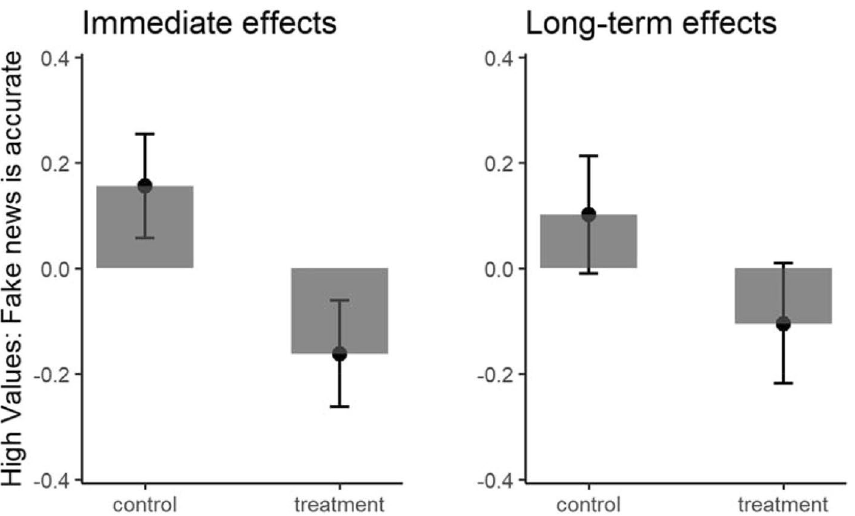
Figure 6. Accuracy evaluation of fake news immediately after the intervention (left panel) and 4 weeks later (right panel). Error bars represent standard errors. The y-axis represents standardized scores in terms of fake news accuracy ratings controlled for real news accuracy ratings. Higher scores indicate that fake news is